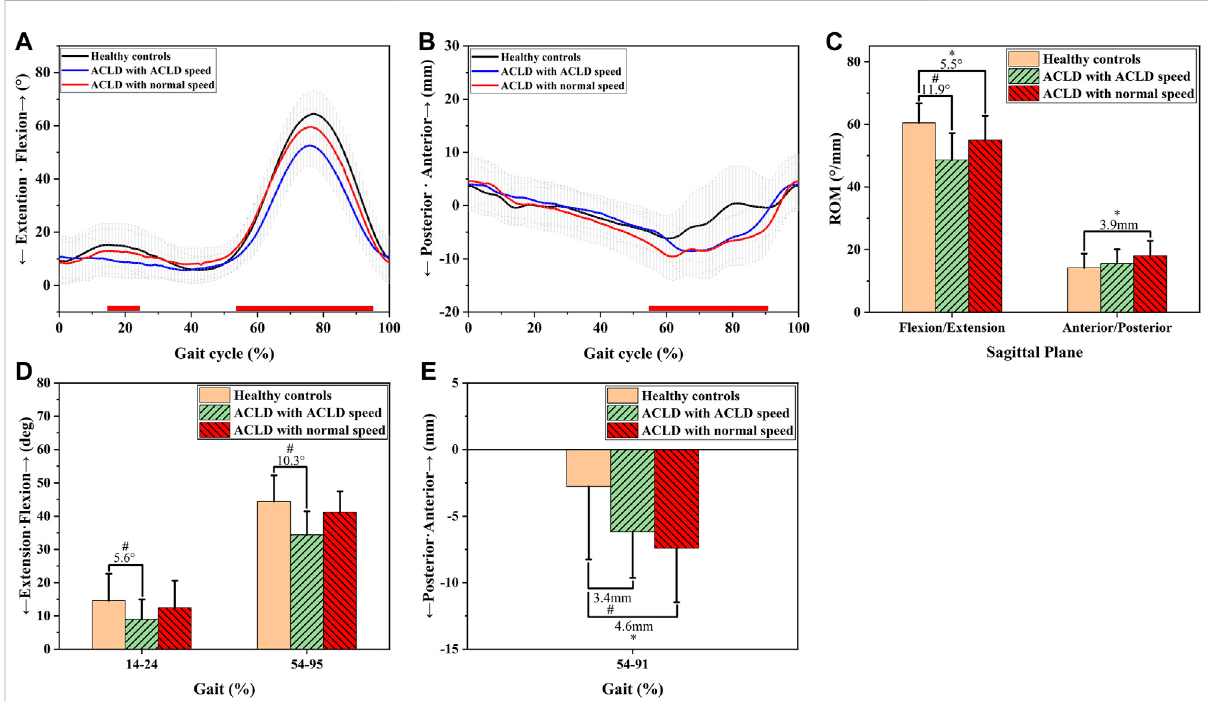
FIGURE 2 Sagittal knee kinematic alterations ofhealthy controls and ACLD patients during gait.Chart (A,D) show walking knee fl exionangle alterations of ACLD patients at ACLD speed and the speed level of healthy controls (normal speed) compared to healthy controls. Chart (B,E) show walking anteroposterior tibial translation alterations of ACLD patients at ACLD speed and the speed level of healthy controls (normal speed) compared to healthy controls. Chart (C) shows the range of motion of fl exion angle and anteroposterior tibial translation of ACLD patients compared to healthy controls during walking. # Signi fi cant kinematic differences were found in ACLD patients who walked at ACLD speed compared to healthy controls. * Signi fi cant kinematic differences were found in ACLD patients who walked at the same speed level as healthy controls (Normal speed) compared to healthy